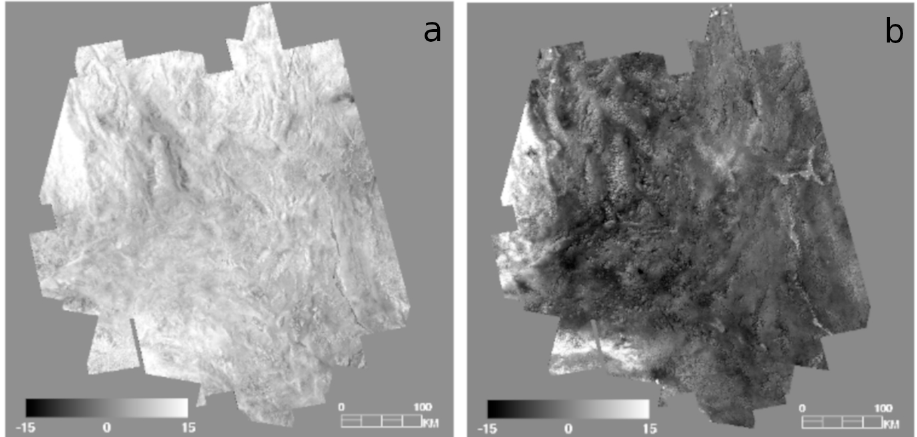
Figure 9. Difference images for MODIS and ASTER eLST in nighttime ( a ) and daytime ( b ), Figure 9. Di ff erence images for MODIS and ASTER eLST in nighttime ( a ) and daytime ( b ), generated generated by convolving ASTER eLST to 1 km resolution and subtracting it from MODIS by convolving ASTER eLST to 1 km resolution and subtracting it from MODIS LST acquired at the LST acquired at the same time as the core image strip date for daytime and nighttime. same time as the core image strip date for daytime and